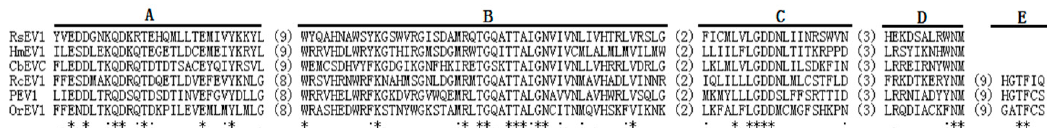
Figure 2. Sequence alignment of RsEV1 RdRp motifs with those of selected viruses in the genus Endornavirus . Horizontal lines, labeled with A to E, above the alignment indicate the five motifs, and the numbers in brackets show the amino acid positions. Asterisks, colons, and dots show the same amino acid residues, conservative, and semi conservative, respectively.